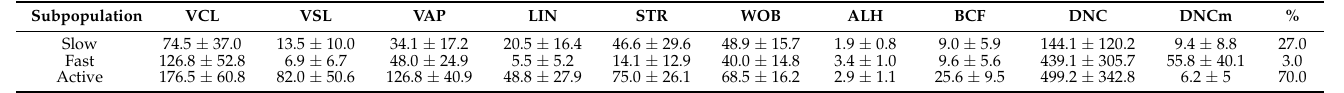
Figure 10. Effects on red deer epididymal sperm motility of melatonin receptors agonists (PHE: Phenylmelatonin; 8MPDOT: 8-Methoxy-2-propionamidotetralin) or antagonists with 10 nM melatonin (LUZ: Luzindole; 4PPDOT: cis-4-Phenyl-2-propionamidotetralin); CTL: Control; CTLm: Control with 10 nM melatonin. Plots show mean ± SEM for each treatment of five different males. ( a ) Percentage of motile spermatozoa; ( b ) Percentage of progressive spermatozoa; ( c ) “Slow” spermatozoa, low velocity and linearity; ( d ) “Fast” spermatozoa, high velocity and linearity; ( e ) “Active” spermatozoa, highest velocity and high lateral movement No significant differences were found among treatments. Table 2. Descriptive statistics of the red deer sperm subpopulations yielded by the clustering of obser- vations from CASA data. Parameters for each subpopulation are summarized by the median ± SD of each CASA variable. The last column is the overall proportion of each